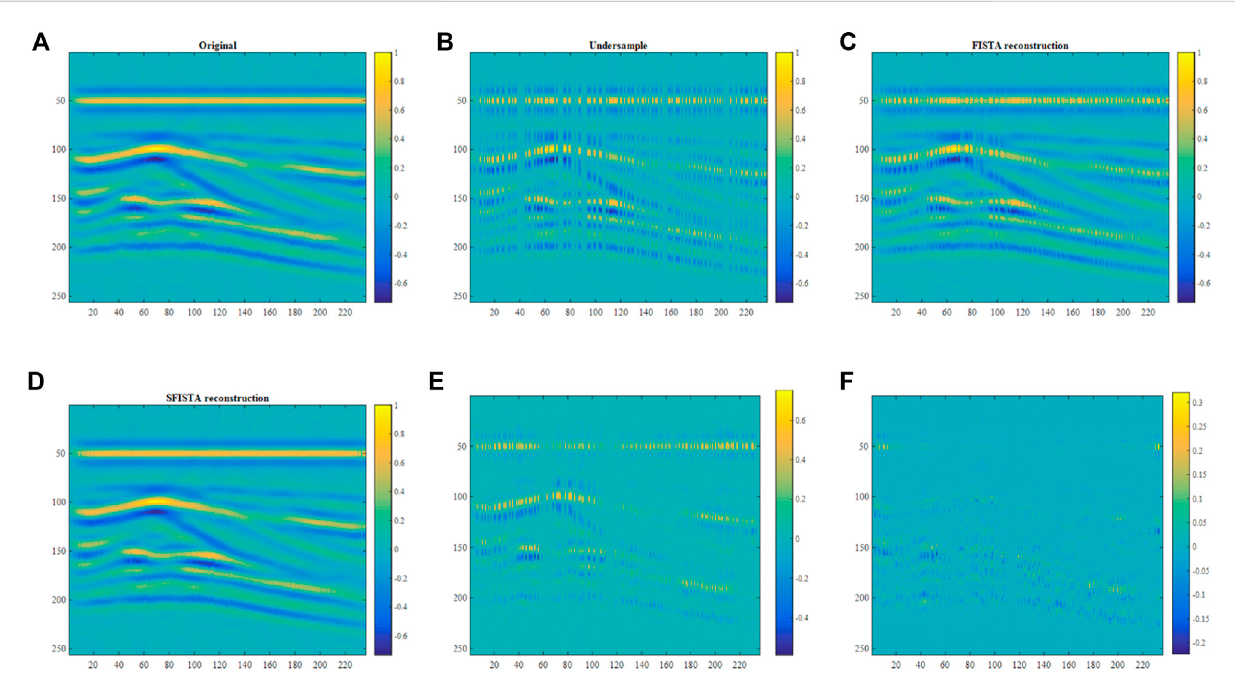
FIGURE 3 Reconstruction results of the coral reef model in the contourlet domain. (A) Original data; (B) 50% of randomly missing data; (C) interpolated data obtained by the FISTA method; (D) interpolated data obtained by the SFISTA method; (E) reconstructed errors obtained by the FISTA method; (F) reconstructed errors obtained by the SFISTA